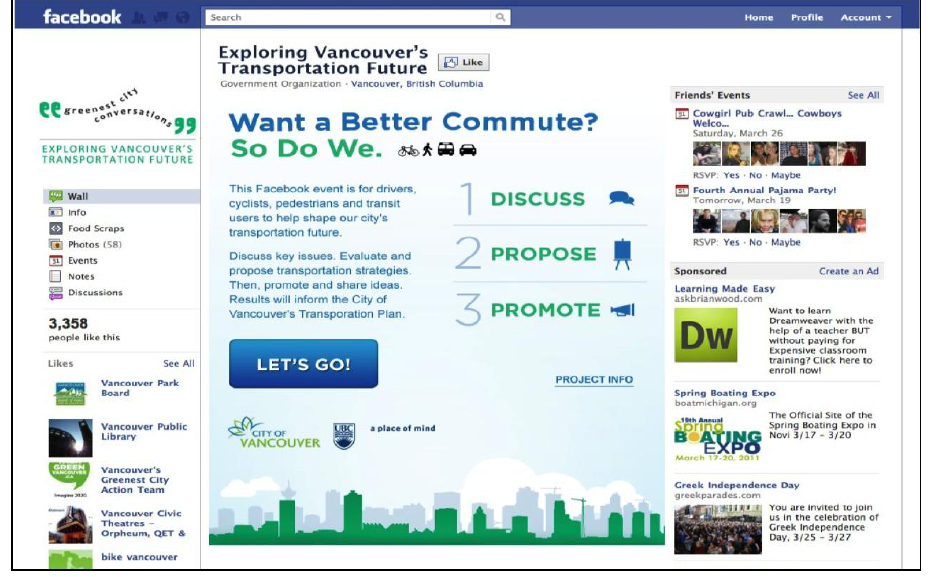
Figure 1: Exploring Vancouver's Transportation Future (EVTF) landing